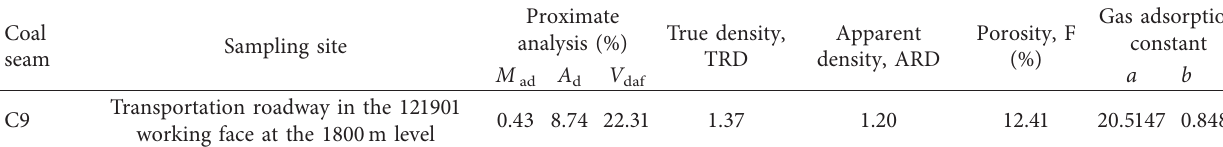
Table 2: Parameters including gas adsorption constant and proximate analysis of the C9 coal seam.